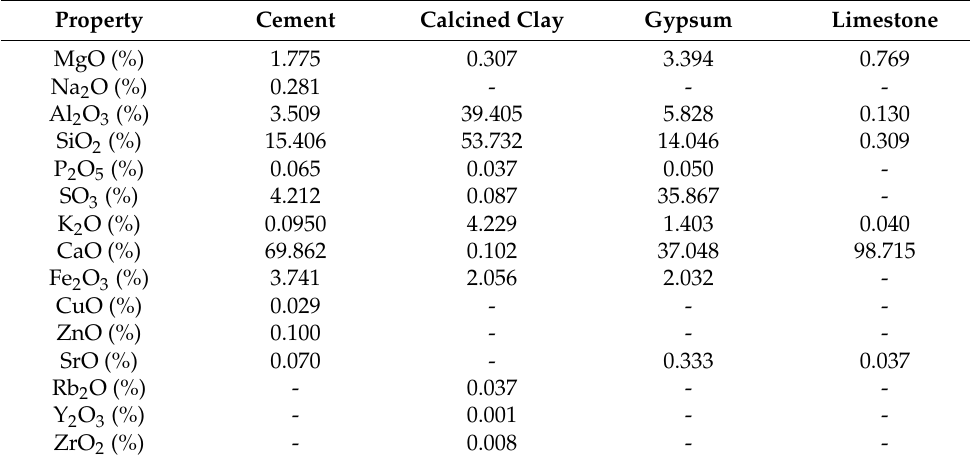
Table 2. Chemical composition of cementitious binders *. Property